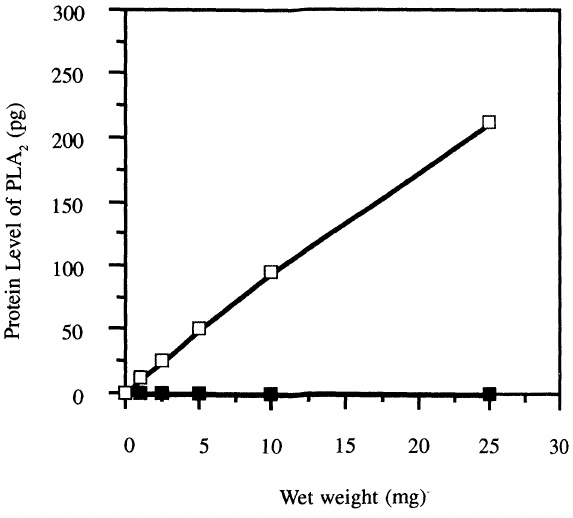
FIG. 1. Levels of group I- and II-phospholipase A (PLA2) as a function of wet weight of gingival tissue. Gingival tissue from a patient with periodontal disease was taken at the time of surgical therapy. The level of II-PLA increased with the increase of tissue weight, but no I-PLA was found.